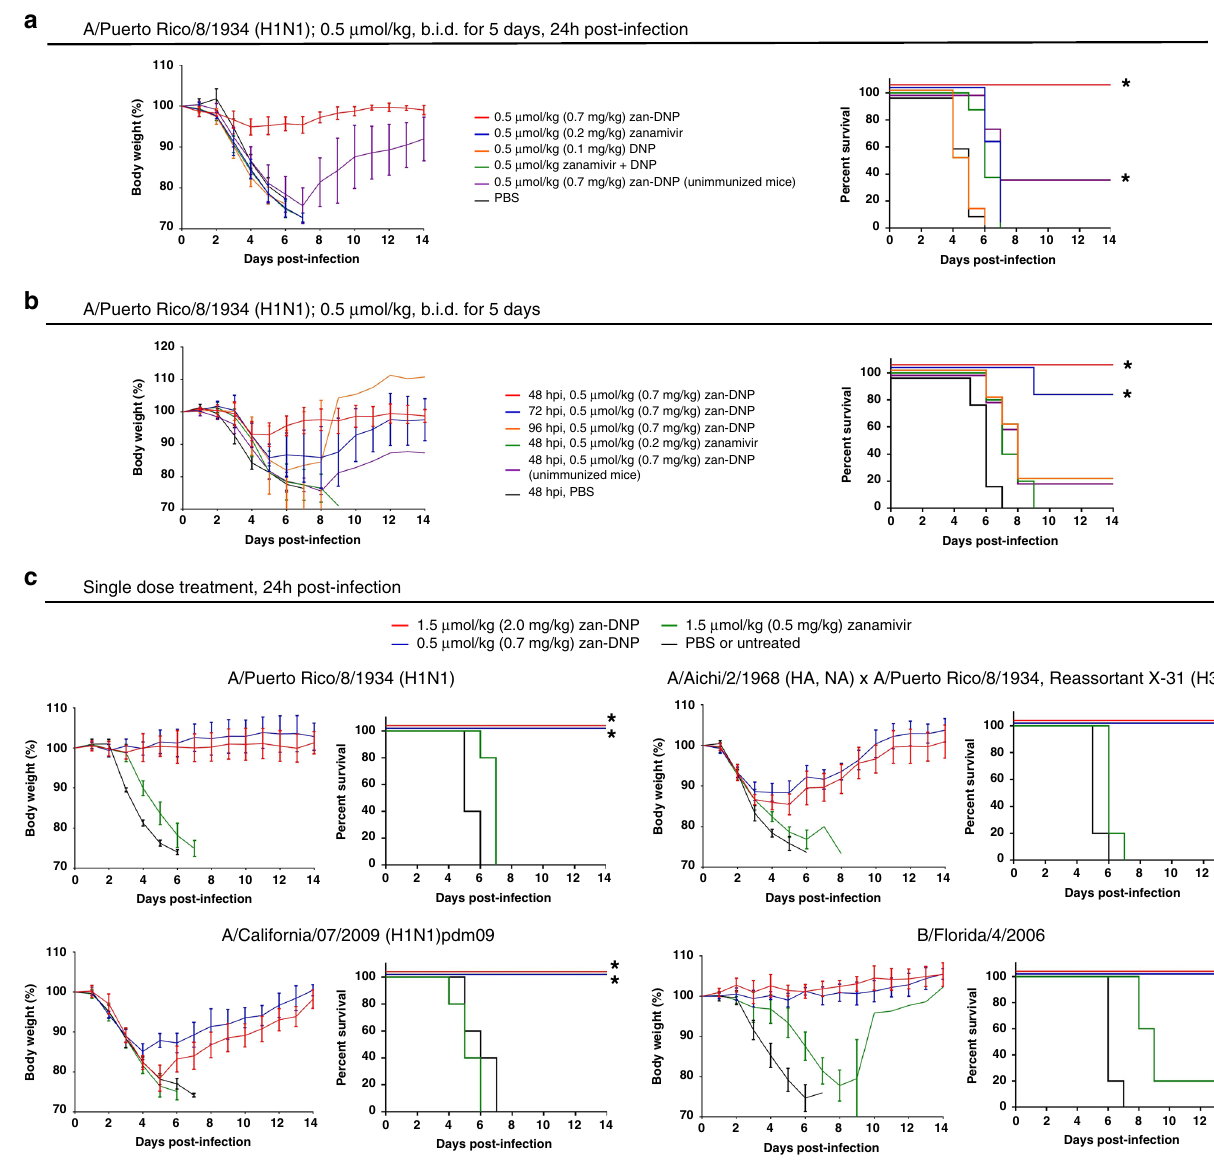
Fig. 4 Therapeutic ef fi cacy of zan-DNP in protecting mice from lethal in fl uenza virus infections. DNP-KLH immunized BALB/c mice were challenged with 100x MLD 50 of the different strains of in fl uenza virus indicated above. Mice were treated with the indicated test articles by intranasal administration (IN) using the dosage regimens indicated above each panel. Mice were counted as dead when they lost either 25% of their initial weight or became moribund. Body weight curves (left panels) and survival curves (right panels) for each treatment are shown. ( a ) compares the ef fi cacy of zan-DNP with its component parts (5 mice/group for zan-DNP and zanamivir treatment groups, 8 mice/group for the rest of the groups). ( b ) examines the effect of different delays between virus inoculation and zanamivir or zan-DNP administration on weight loss and animal survival (5 mice/group). ( c ) investigates the potency of a single dose of either zanamivir or zan-DNP on the same parameters in mice infected with viruses indicated above (5 mice/group). Statistical differences between PBS and drug treatment groups were determined by two-sided log-rank test (* P < 0.005, see exact P values in Supplementary Table 1). Body weight change (%) are presented as mean values ±